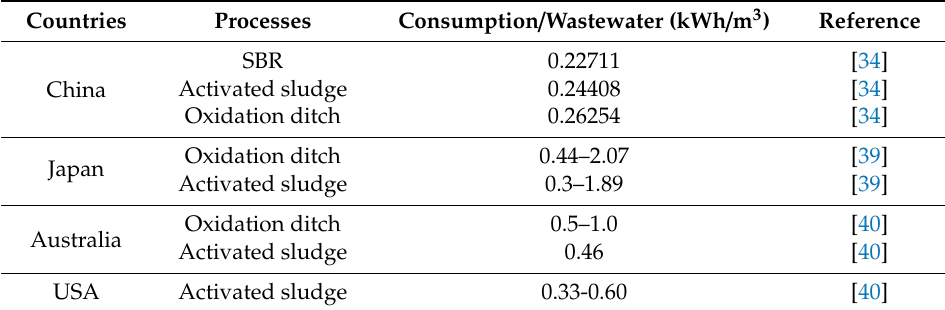
Table 1. Energy consumption of wastewater treatment in di ff erent countries and